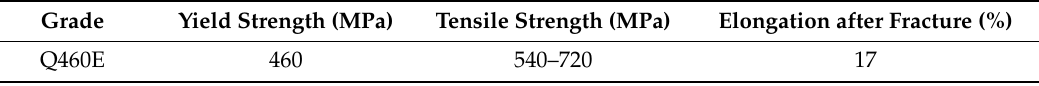
Table 1. Mechanical composition of the Q460E substrate